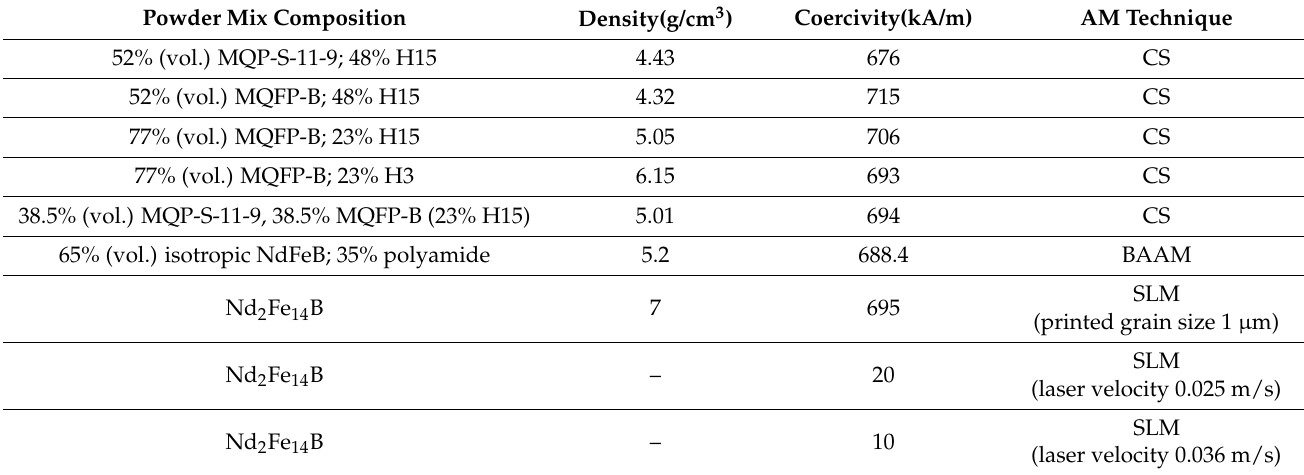
Table 3. Attributes of various AM produced magnetic materials